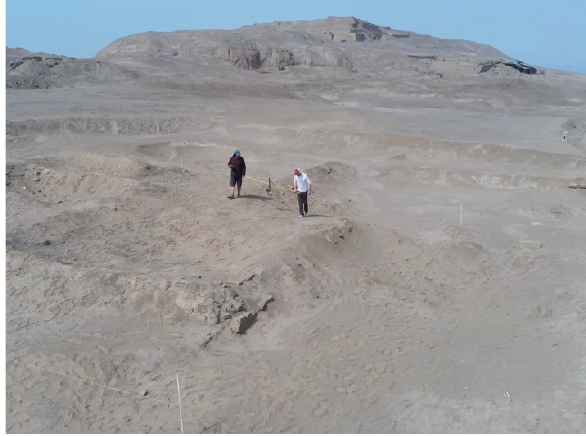
Figure 7 . Aerial-GPR test on the B15, Pachacamac